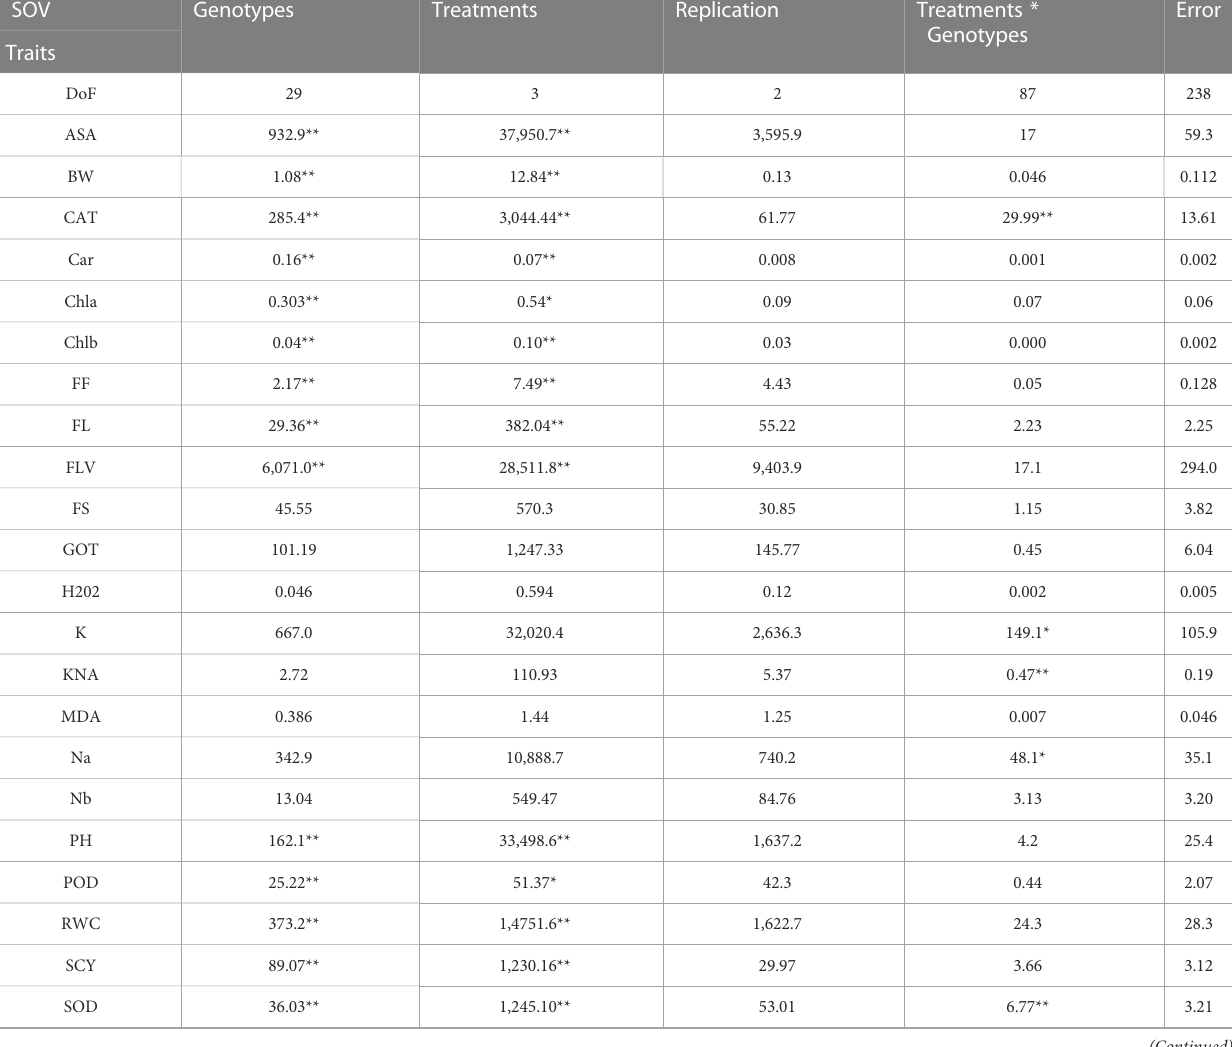
TABLE 2 Second year mean square values for various agro-physiological, biochemical, and fi ber quality traits of 30 cotton genotypes under four treatments. SOV Genotypes Treatments Replication Treatments *